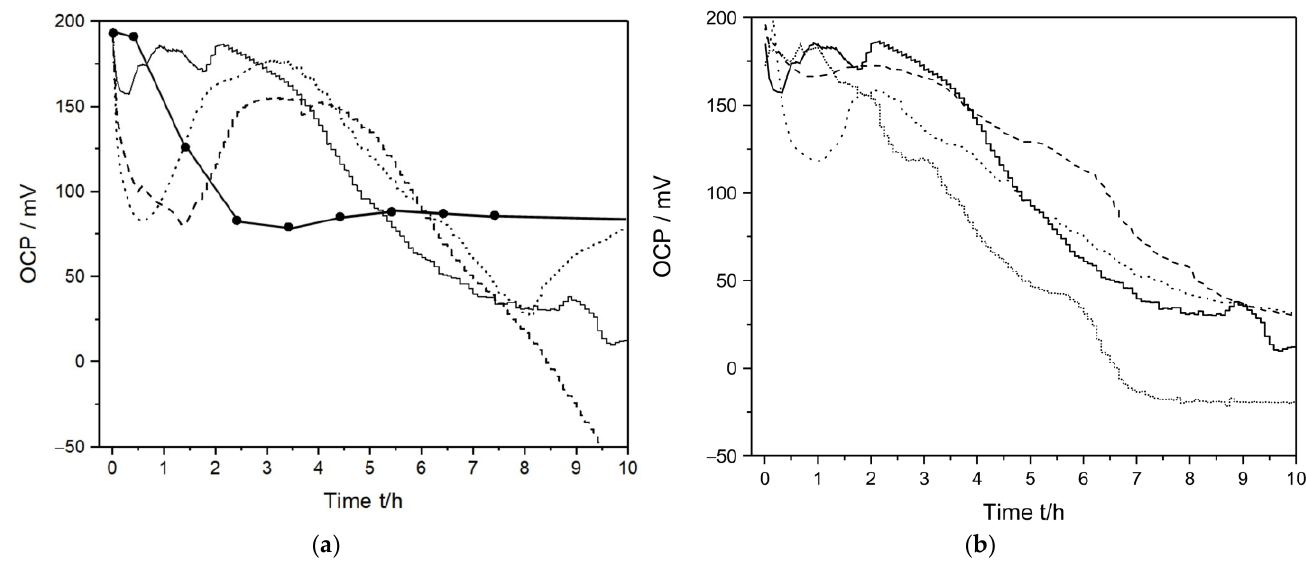
Figure 4. ( a ) Bacteria in human urine (volunteer one and afternoon collection), 200 µL (solid); 20 µL (dotted), 10 µL (dashed) or no (solid with circles) of a bacterial aliquot was added, ( b ) 200 µL of bacterial aliquots was added to different urine samples gathered at different times of the day and from two different volunteers, volunteer one and afternoon urine (solid), volunteer one and morning urine (dashed), volunteer two and afternoon urine (short dots), volunteer two and morning urine (dotted).